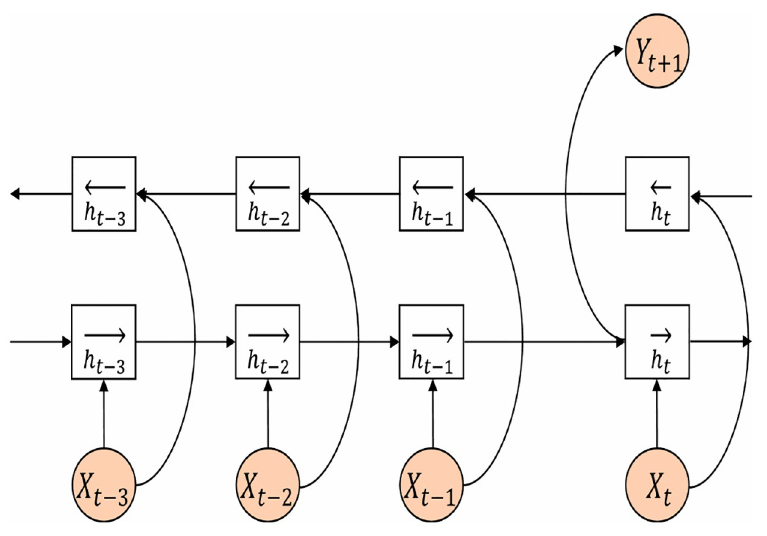
Fig 2. Two-way GRU